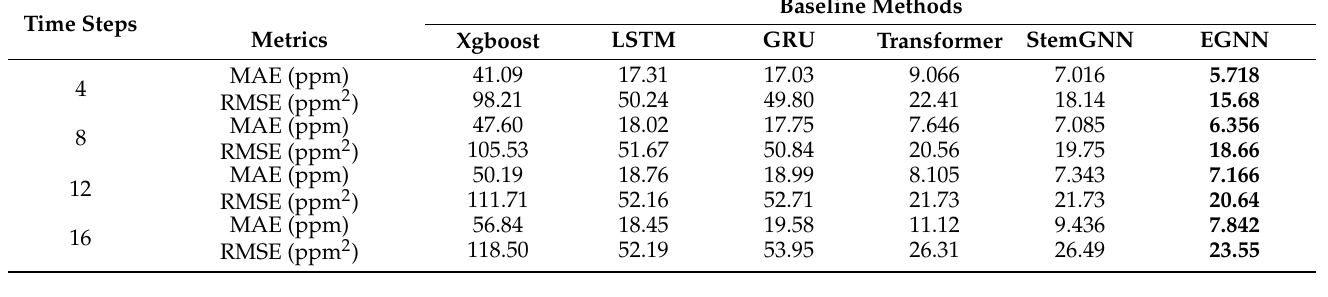
Table 5. Prediction results of different time steps based on EGNN and the other five baseline mod- els.